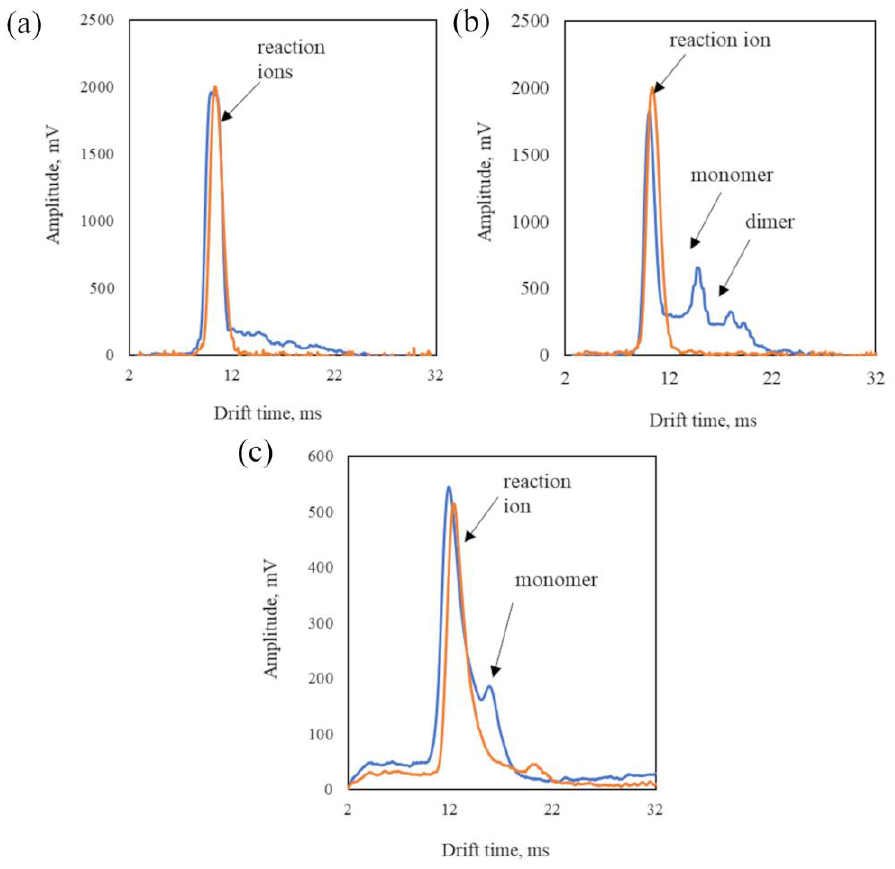
Figure 5. IMS spectrogram of ( a ) air analysis, ( b ) soman, and ( c ) sulfur mustard (for negative ions). Standard measurement conditions are a gas flow of 1 dm 3 /min. The temperature is 40°C in the DT IMS chamber, but the air temperature ranges from − 30 to 50°C. The content